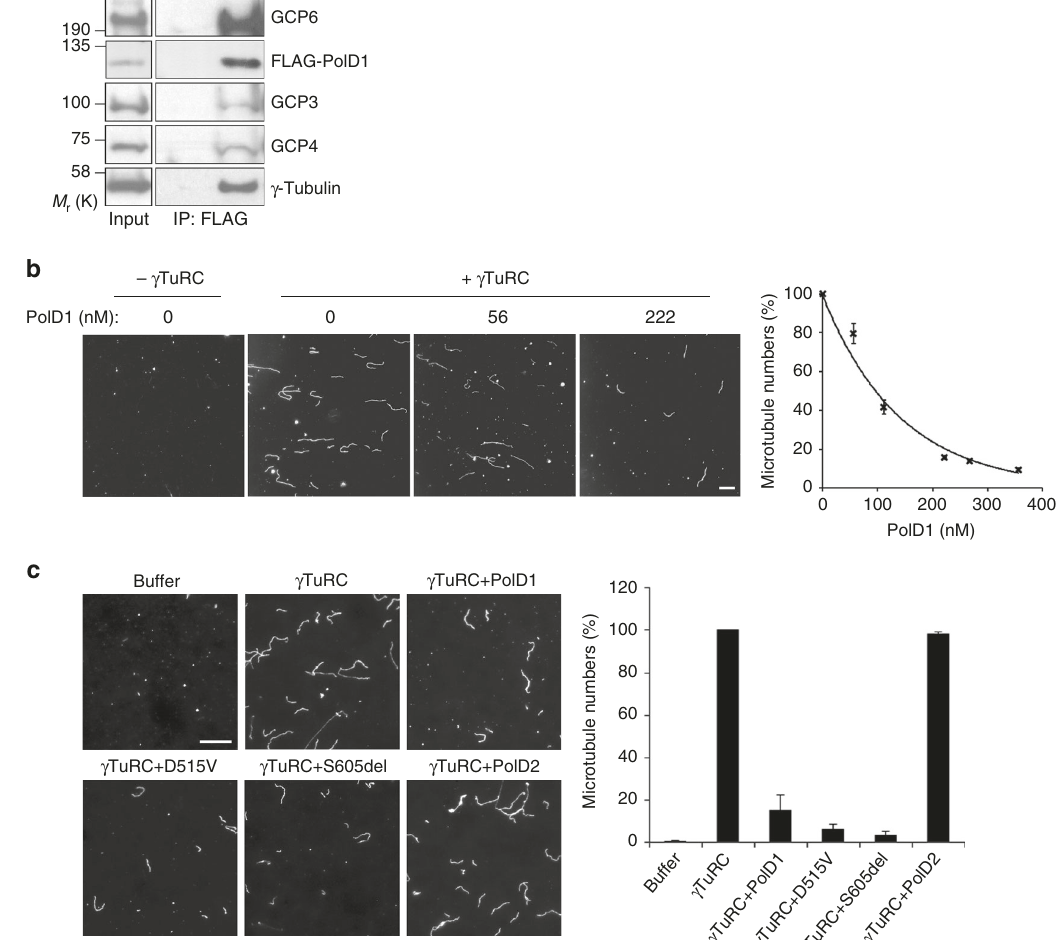
Fig. 2 PolD1 inhibits γ TuRC-induced microtubule nucleation in vitro. a The recombinant protein FLAG-PolD1 was tested for binding with puri fi ed γ TuRCs. FLAG-PolD1 was absent in the control. After anti-FLAG immunoprecipitation, the input γ TuRCs and the immunoprecipitates were immunoblotted. b Puri fi ed γ TuRCs reconstituted with the γ TuRC stimulator CDK5RAP2(51 – 200) were used in the microtubule-nucleating assay together with PolD1 at various concentrations. Representative microscopic fi elds of polymerized microtubules are shown. The data are presented as means ± s.e.m. of three independent experiments. c Puri fi ed γ TuRCs were used for microtubule nucleation in the absence of CDK5RAP2(51 – 200). PolD1 wild-type and mutants (D515V and S605del) and PolD2 were added at an excessive amount (356 nM). Shown are representative images of polymerized microtubules, and the data are presented as means ± s.d. of three independent experiments. Scale bars , 10 μ